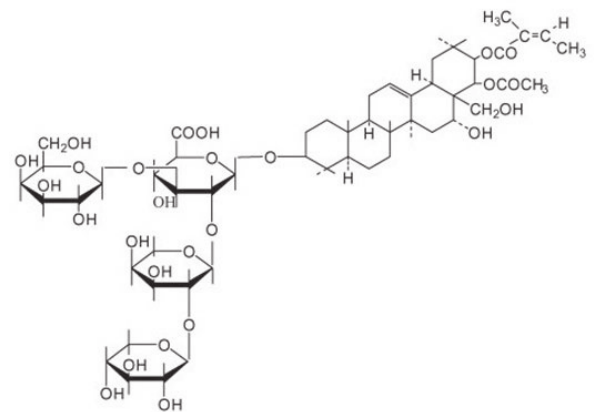
Figure 5. The molecular structure of tea saponin molecule as an example of a non-ionic biosurfactant.